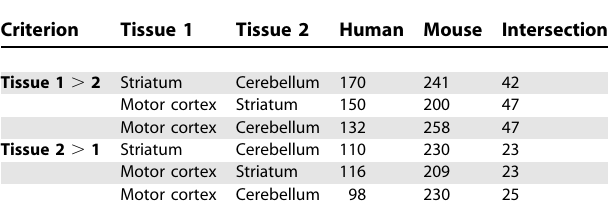
Table 4. Mouse and Human Brain Regions Share a Higher Number of Overrepresented Functional Groups than Would Be Expected by